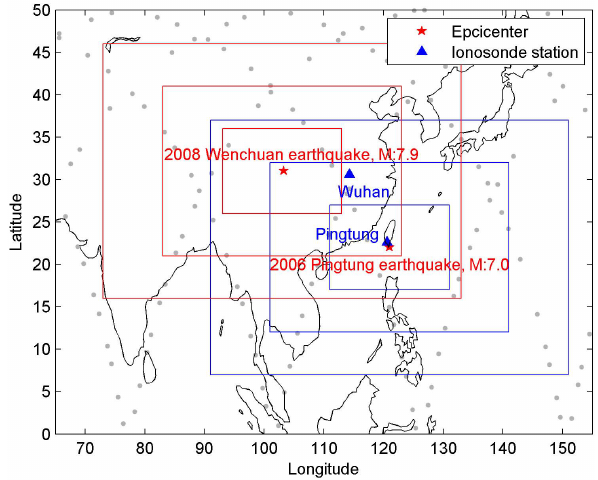
Fig. 6. The areas where HHT is conducted for the Wenchuan (red squares), and Pingtung Doublet (blue squares) earthquakes. The epicenters are located in the center of the squares and marked by red stars. Hilbert spectra in these three regions for two large earth- quakes are displayed in Figs. 10 and 11. For the Pingtung Dou- blet earthquake, the first area is 17–27 ◦ N in latitude, 111–131 ◦ E in longitude. The second area is 12–32 ◦ N in latitude, 101–141 ◦ E in longitude. The third area is 7–37 ◦ N in latitude, 91–151 ◦ E in longitude. For the Wenchaun earthquake, the first area is limited to 26–36 ◦ N in latitude, 93–113 ◦ E in longitude. The second area is 21–41 ◦ N in latitude, and 83–123 ◦ E in longitude. The third area is 16–46 ◦ N in latitude, and 73–133 ◦ E in longitude. The gray dots denote the location of TIMED/SABER Tn profiles on 12 May